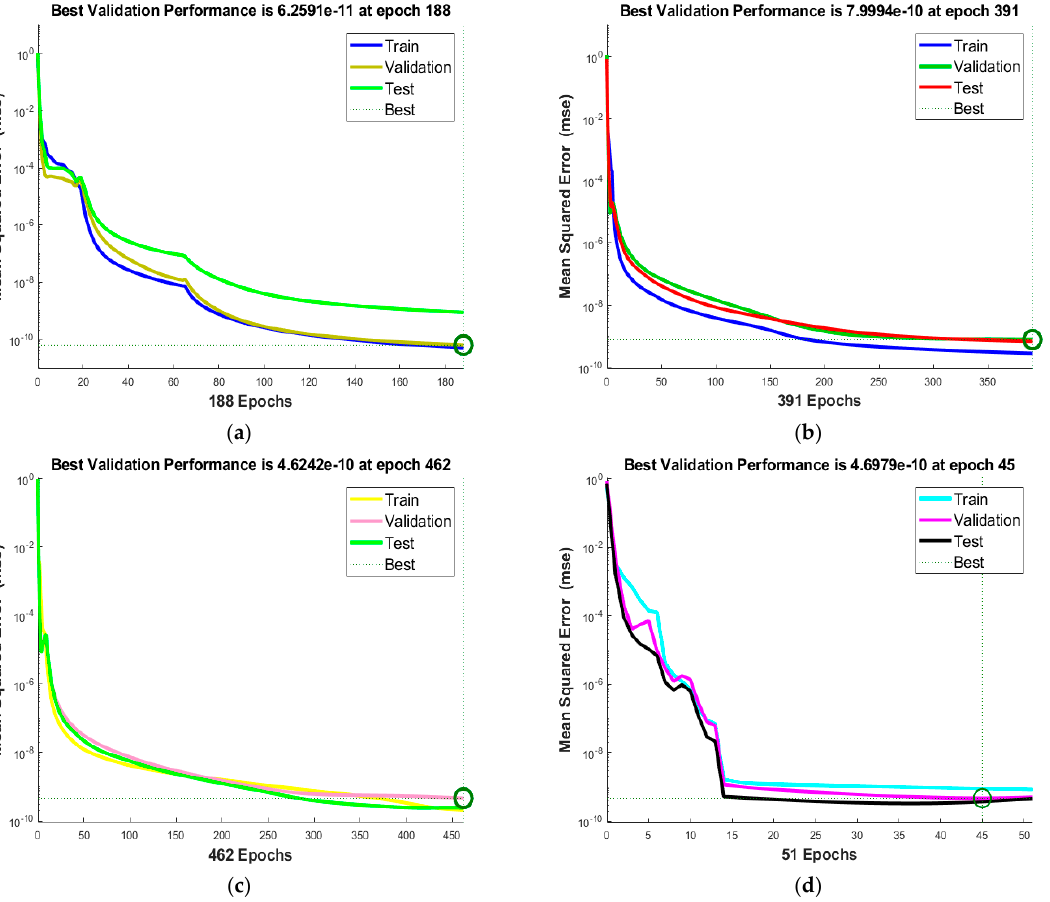
Figure 3. ( a – d ) Performance of MSE of proposed ANNLMB for solving heat transfer of spinning nanofluid. ( a ) MSE: Scenario 1; ( b ) MSE: Scenario 2; ( c ) MSE: Scenario 3; ( d ) MSE: Scenario 4.